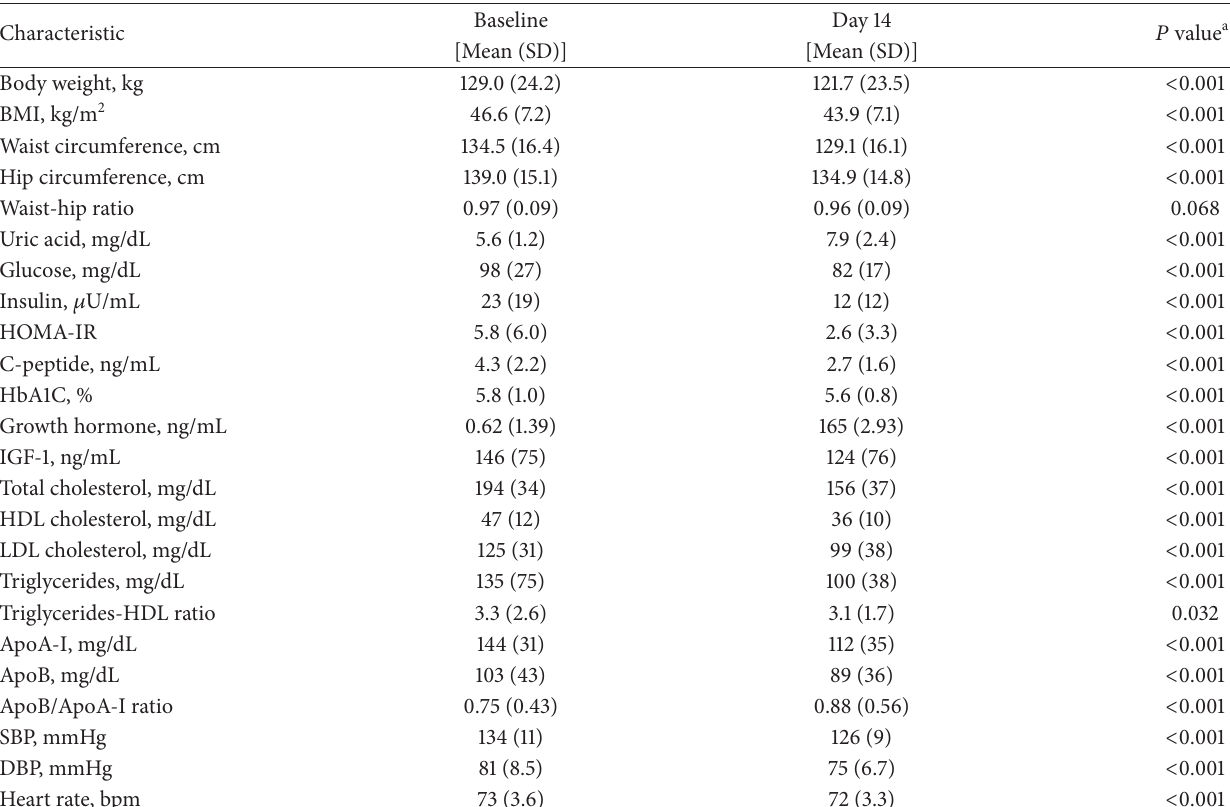
Table 4: Changes in anthropometric, clinical, and metabolic features after the intervention (efficacy analysis; intention-to-treat population [ 𝑁 = 364